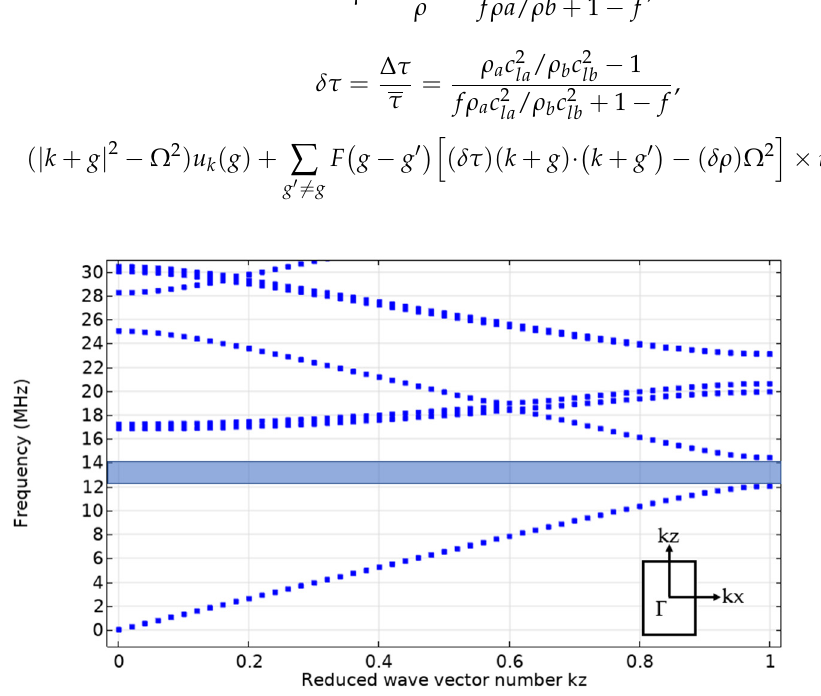
Figure 3. Band diagram of the phononic crystal periodic element (along kz).